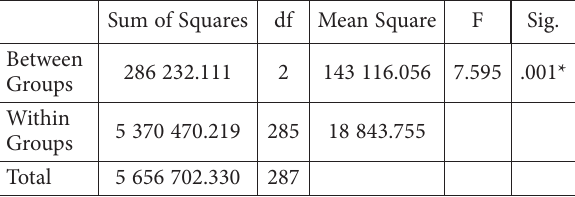
Table 2. Analysis of variance of salinity (EC) values in the experiments with different filtration materials Sum of Squares